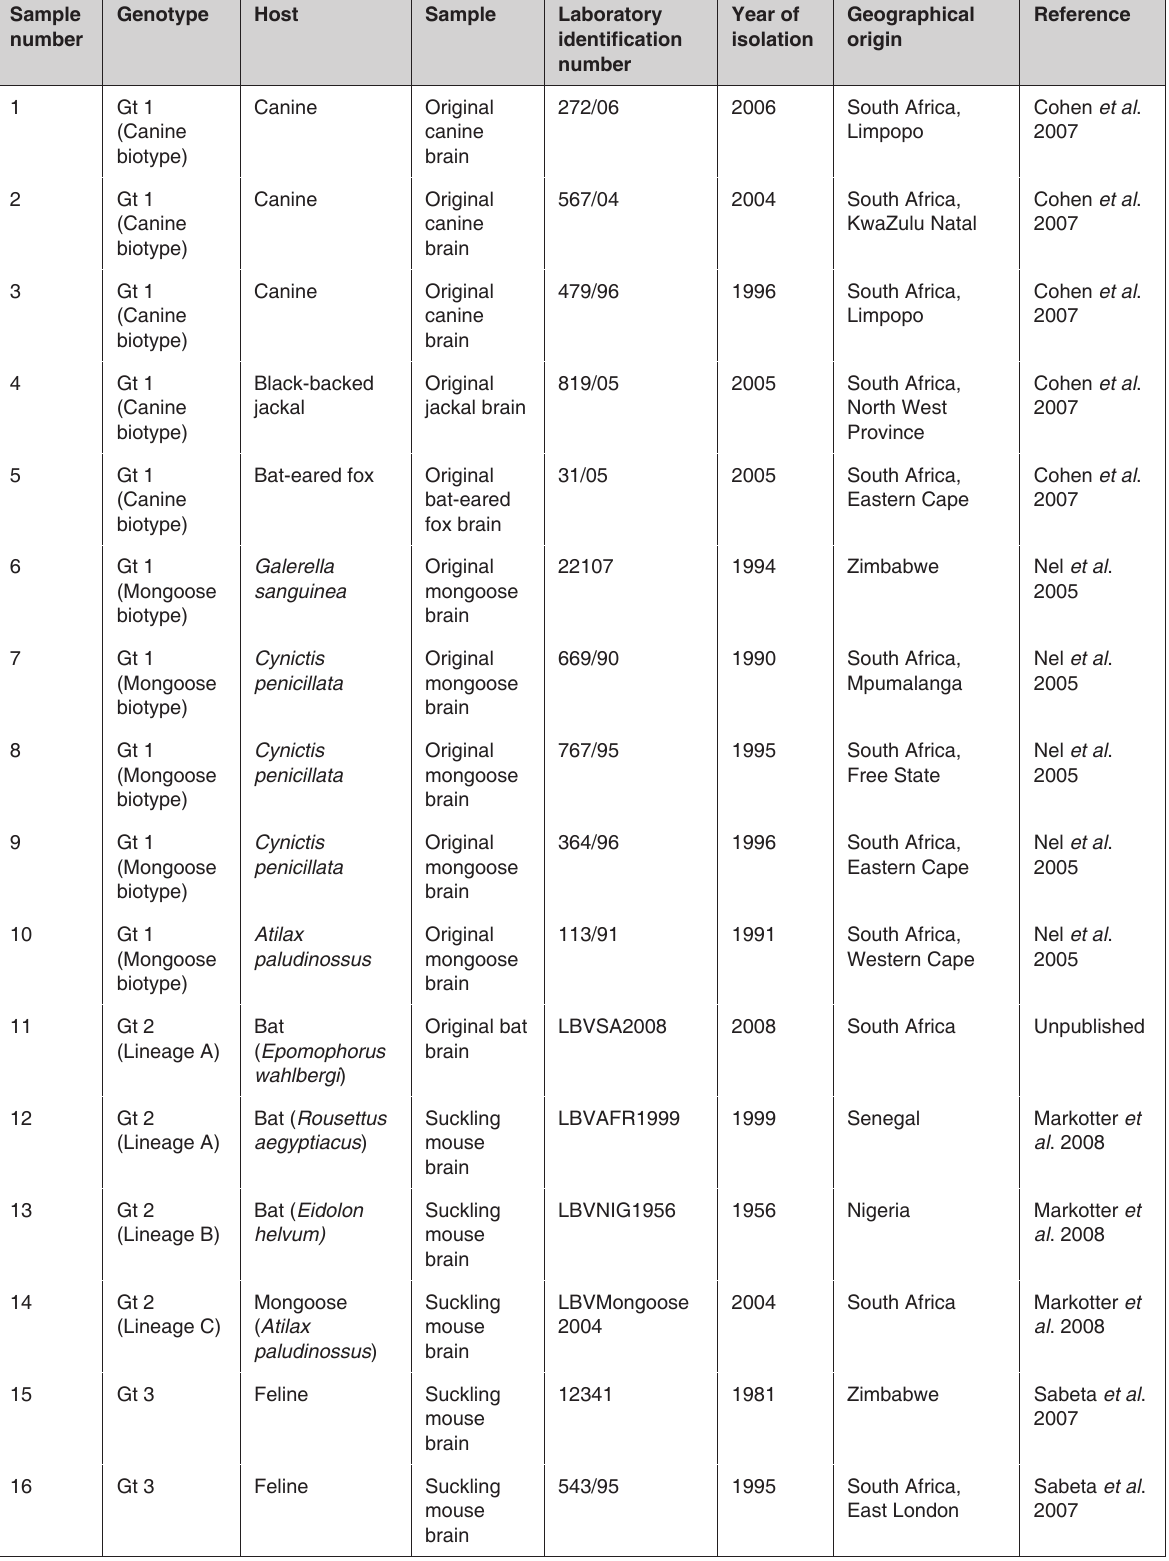
TABLE 1 List of lyssavirus-positive samples included in the evaluation of the specificity of the rapid immunodiagnostic test (RIDT) against African